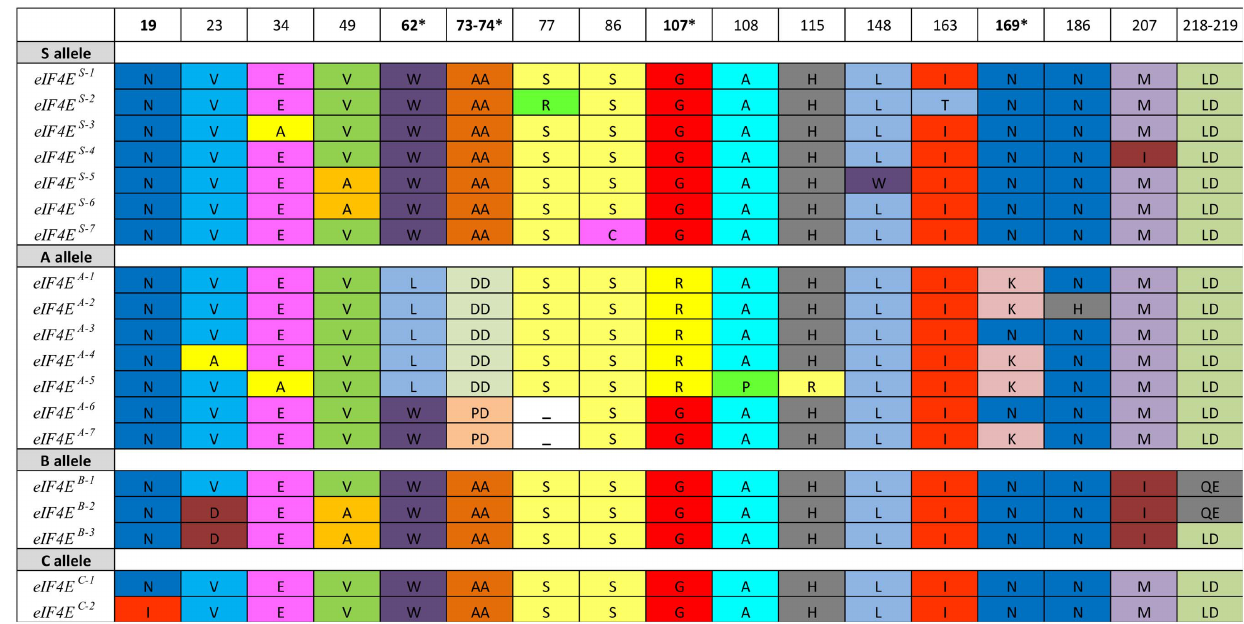
Figure 3. Summarized amino acid exchanges of identified 19 eIF4E alleles. Asterix indicates the position of exchanges previously identified as crucial for resistance.